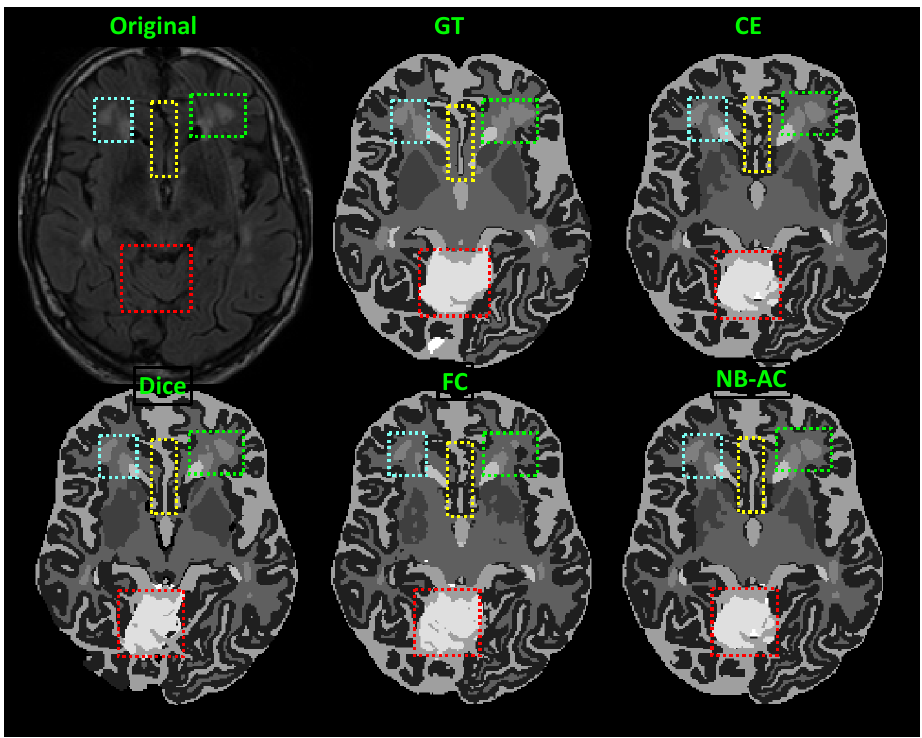
Figure 9. Comparison between our results against other loss functions on the Unet framework. The image is from the MRBrainS 2018